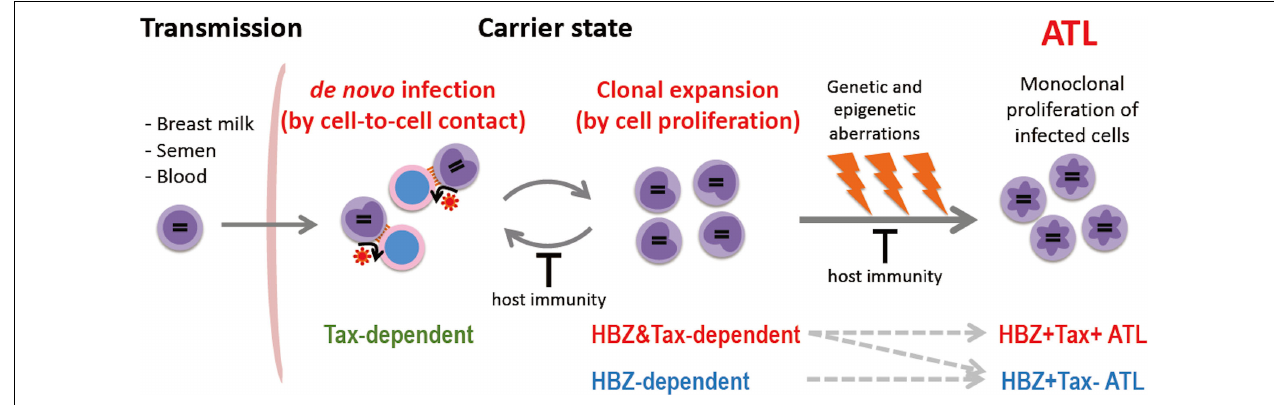
FIGURE 1 | Propagation of HTLV-1-infected cells in vivo . HTLV-1 is transmitted by infected cells in breast milk, semen, and blood, and establishes infection by cell-to-cell contact. HTLV-1 spreads in vivo by de novo infection and clonal expansion. Tax is required for de novo infection since Tax drives viral replication. HBZ is critical for clonal expansion. Host immunity controls the number of infected cells and their clonality. In the carrier state, infected cells survive for a long period; genetic/epigenetic aberrations accumulate, and a malignant clone may emerge, resulting in ATL. Approximately half of ATL cases develop in a Tax-independent manner (i.e., Tax– ATL), while the other half retain the capacity to express Tax (Tax+ ATL).